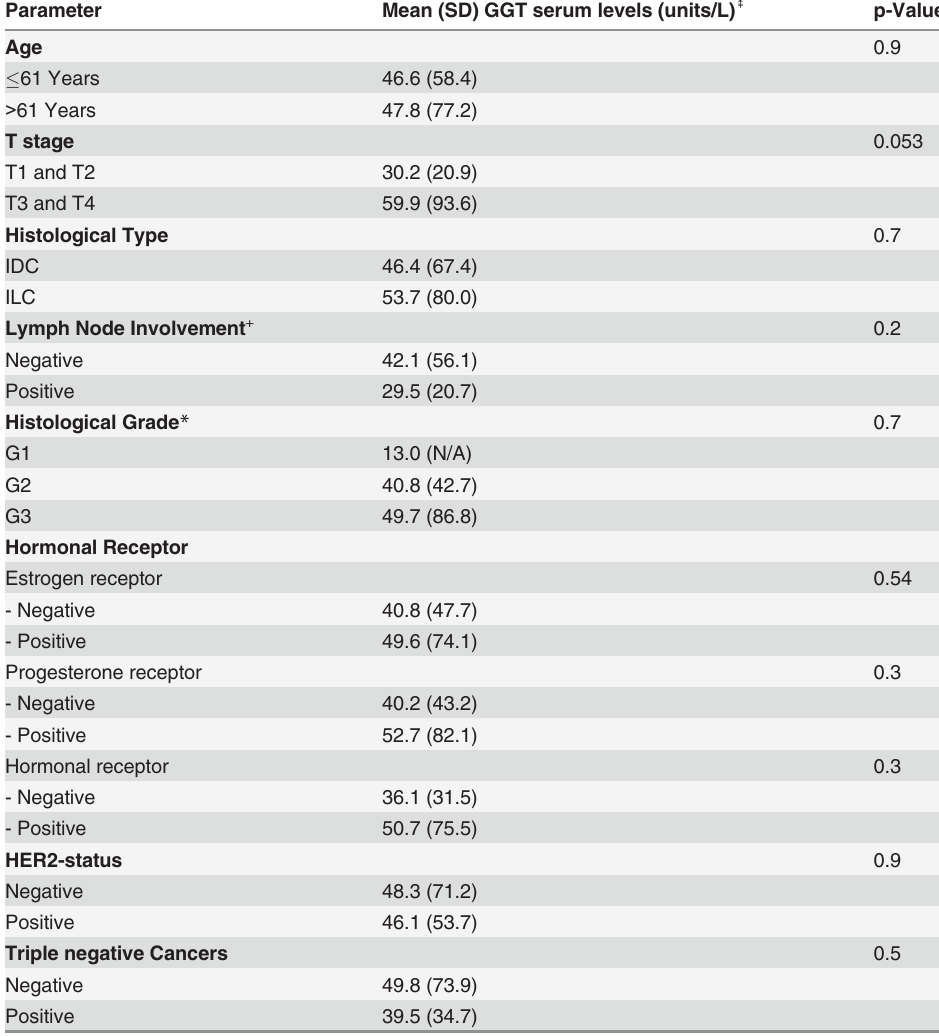
Table 2. Pre-therapeutic GGT serum levels of patients with primary metastatic breast cancer broken down by clinical-pathological parameters.